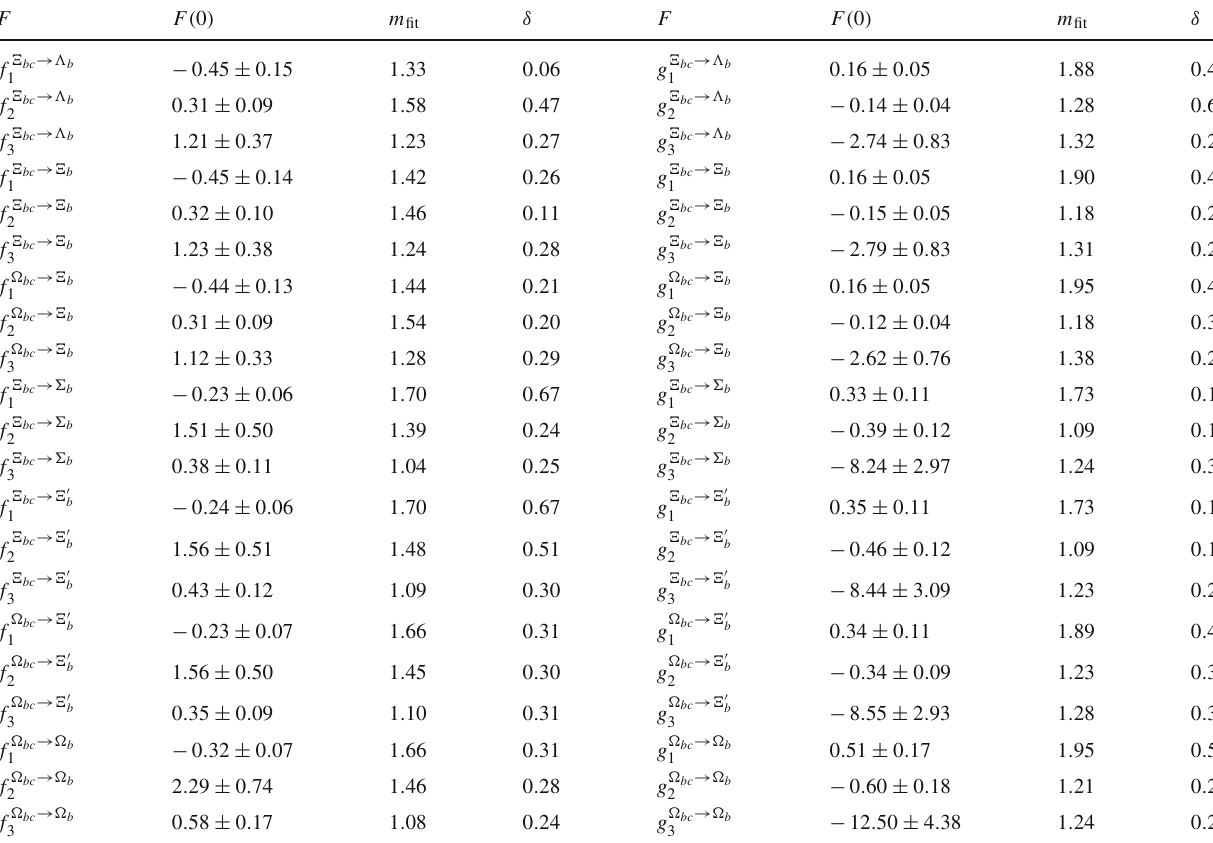
Table 10 The form factors for the bc sector with c quark decay. Equa- tion (37) is adopted as the fit formula. The results for (cid:2) bc → (cid:6) b √ → (cid:6) 0 correspond to (cid:2) + . A factor 2 should be multiplied to F ( 0 ) bc b → (cid:6) − for (cid:2) 0 . The form factors f 1 , g 1 and g 2 in the (cid:2) bc → (cid:2) (cid:3) b bc